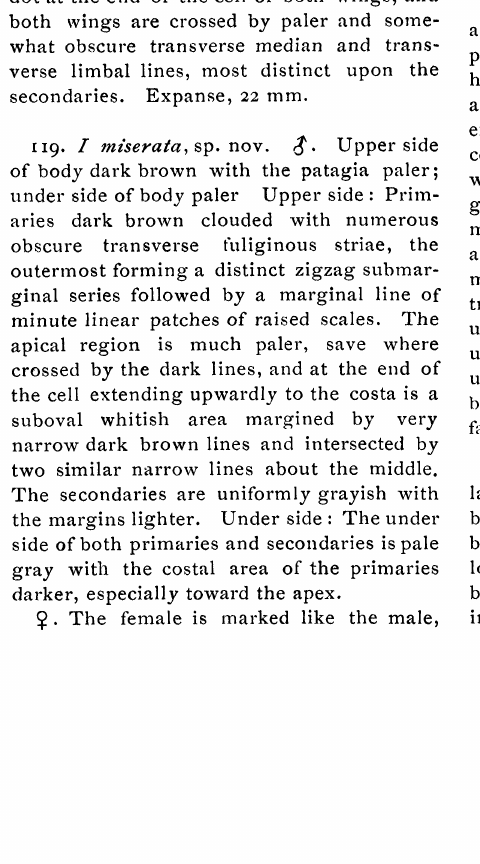
but is considerably larger and the markings are not quite so distinct. Expanse, ’, 8 mm.; ,3 6mm. ’. Collar I2O. I. circumdala, sp. nov. and upper side of thorax pale reddish-brown; upper side of abdomen darker brown:lower side of thorax and abdomen pale brown. Upper side: The upper side of the primaries is dark brown, obscurely spotted and clouded with blackish. The outer margin and the inner margin are broadly pale reddish-brown of the same shade as the upper side of the thorax. There are a few obscure whitish dots near the apex, an obscure submarginal series of minute brown dots, and the fringes are dark brown checked with pale reddish- brown. The secondaries on the upper side . are pale fulvous. Under side: The wings are marked very much as in L albibasalis. Expanse, 26 ram. Body 121. L 3runneicosta, sp. nov. and legs pale luteous. Upper side of the . primaries is very pale luteous with the costa heavily marked with dark brown, especially at the middle, where the dark brown shade extends inwardly, covering the end of the cell. The outer margins are also clouded with brown and about the middle of the mar- ginal area is a very heavy dark brown spot, margined externally by pale luteous. There are also one or two dark brown subapical marks and obscure transverse median and transverse limbal lines. The secondaries are uniformly very pale yellowish-gray. The under side of both wings is colored like the . upper side of the secondaries, save that the brown costal mark on the primaries reappears faintly upon the lower side. Expanse, 22 ram. The col- 122. [. albicoslata, sp. nov. lar and upper side of the thorax are dark brown; the upper side of the abdomen pale brown pectus and forelegs dark brown lower side of thorax and abdomen pale brown. Upper side: The primaries have the inner half broadly rich brown marked